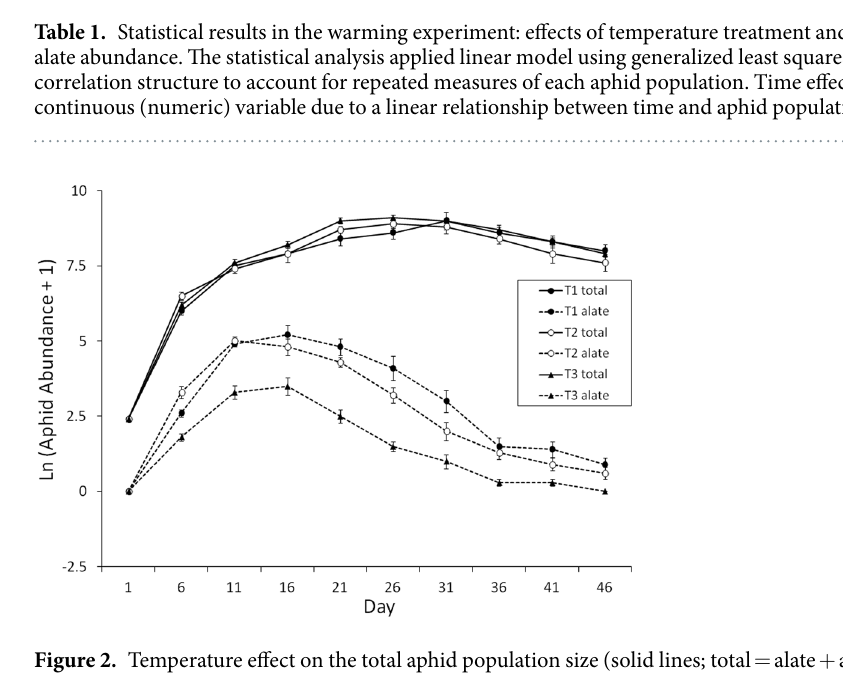
Figure 2. Temperature effect on the total aphid population size (solid lines; total = alate + apterous) and alate population size (dashed lines) on a soybean plant over time (Mean ± SE; T1 = 24.5 °C, T2 = 26.5 °C, T3 = 28.5